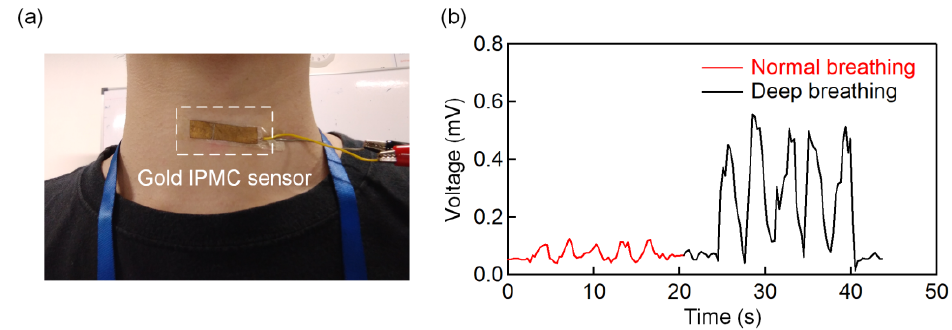
Figure 4. ( a ) Photograph and illustration of how the throat sensor is attached to the throat. ( b ) Output voltages from the IPMC sensor for normal breathing and deep breathing.